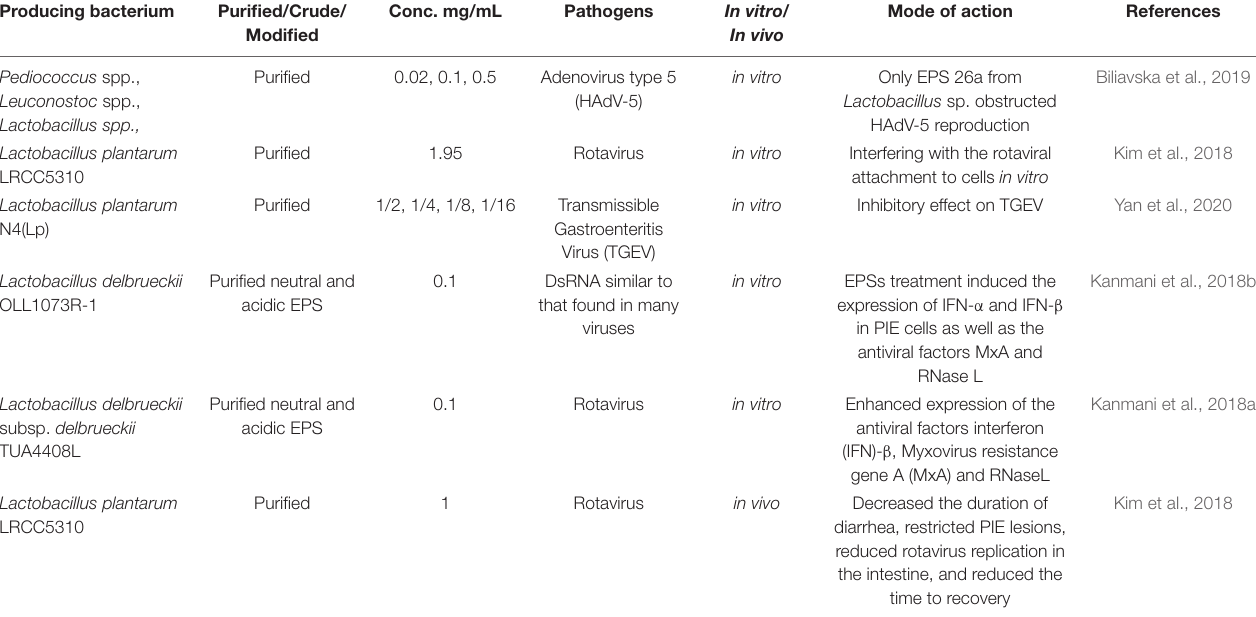
TABLE 4 | Antiviral activities of LAB-derived